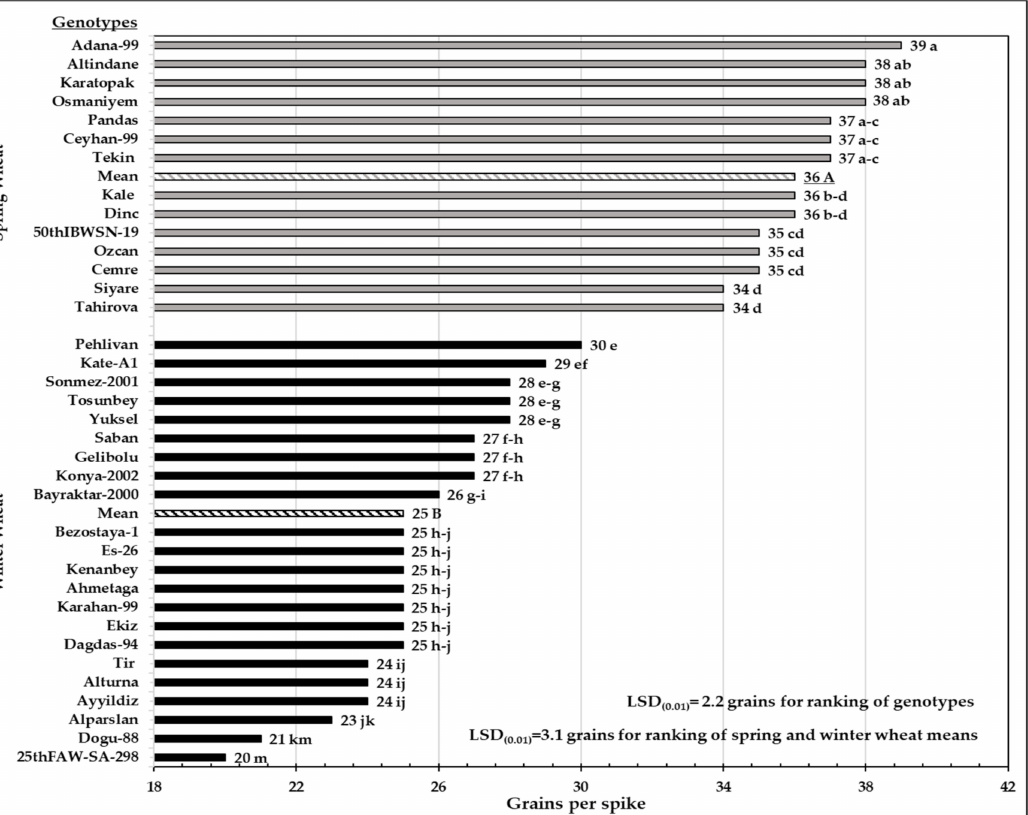
Figure 8. Comparing winter wheat genotypes with spring wheat genotypes for grains per spike over two cropping seasons. Genotypes with the same letter are not significantly